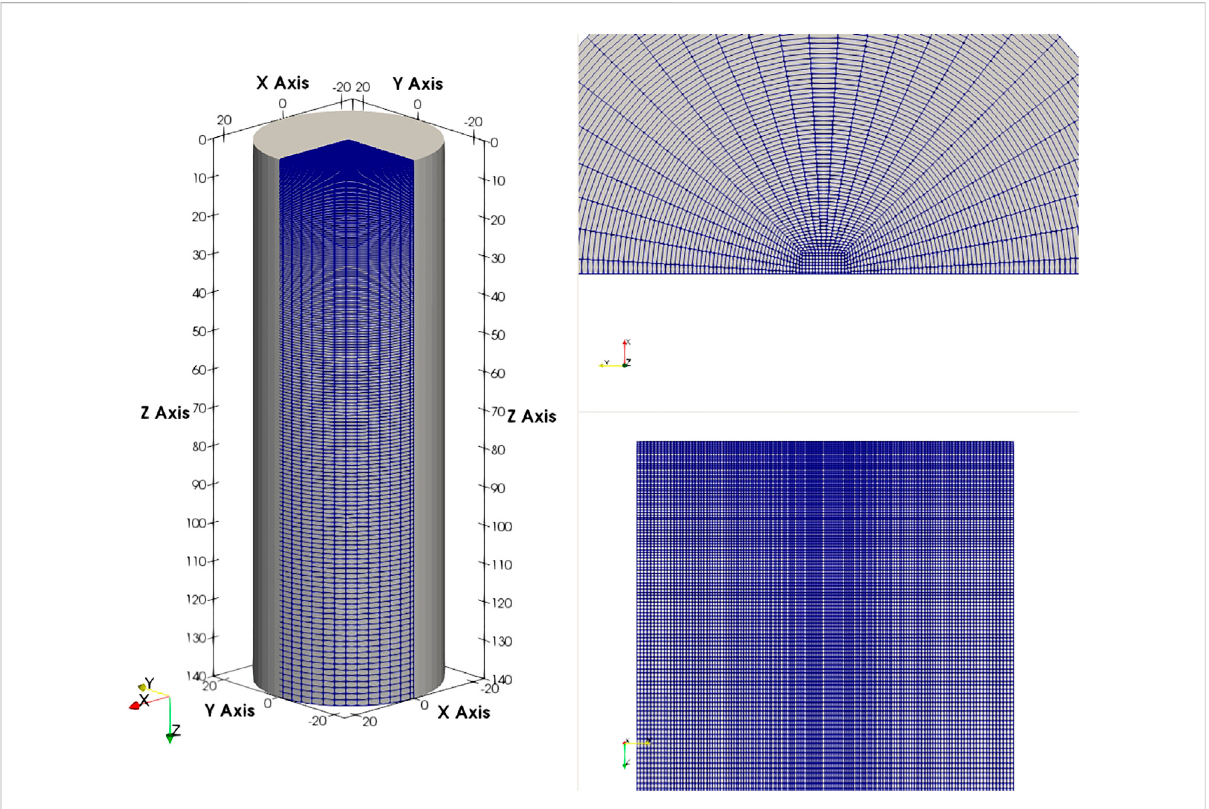
FIGURE 1 Cylinder dimensions and central re fi